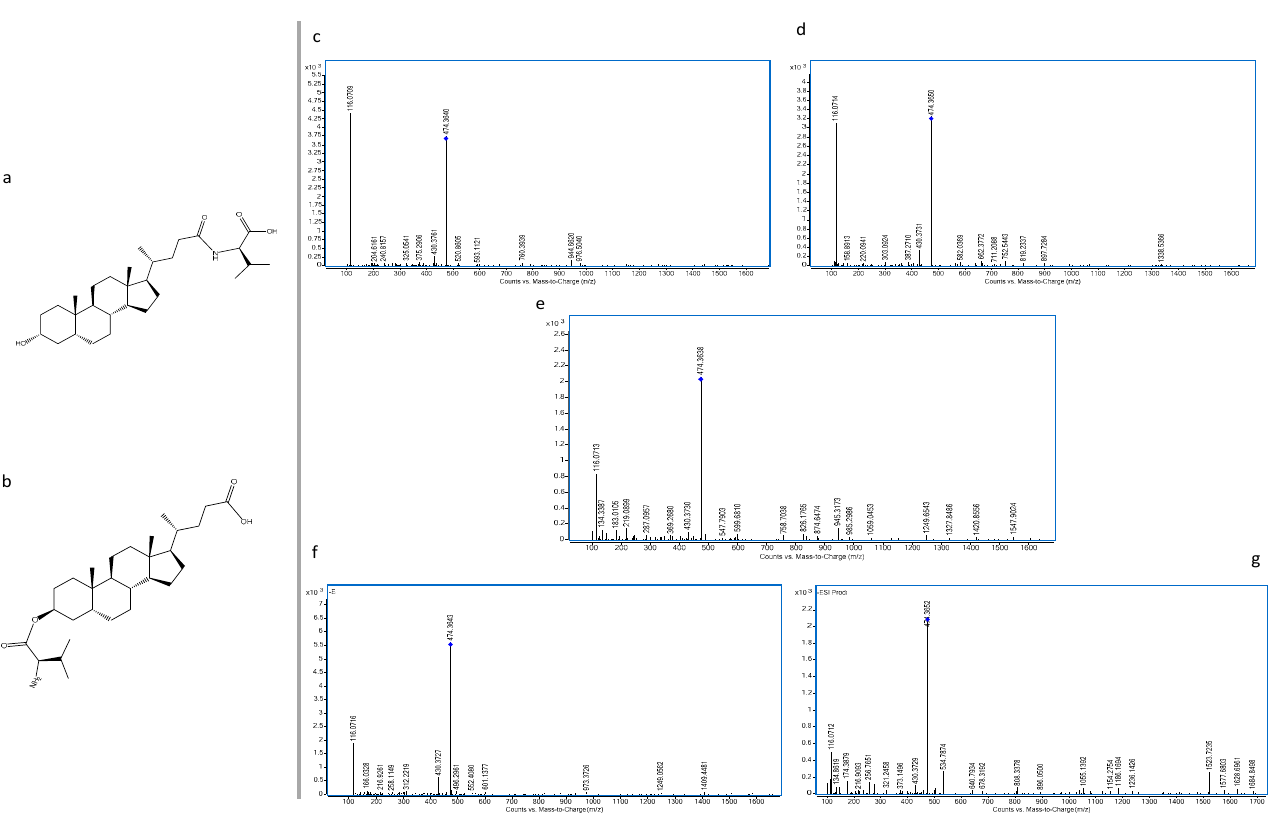
Figure 5. MS/MS spectra of valine conjugates. ( a ) microbially conjugated BA in the 24 acyl site; ( b ) microbially conjugated BA by esterification of C3; ( c ) MS/MS fragments of valine conjugate confirmed at 17.15 min; ( d ) MS/MS fragments of valine conjugate confirmed at 16.80 min; ( e ) MS/MS fragments of valine conjugate confirmed at 16.16 min; ( f ) MS/MS fragments of valine conjugate confirmed at 15.48 min; ( g ) MS/MS fragments of valine conjugate confirmed at 14.83